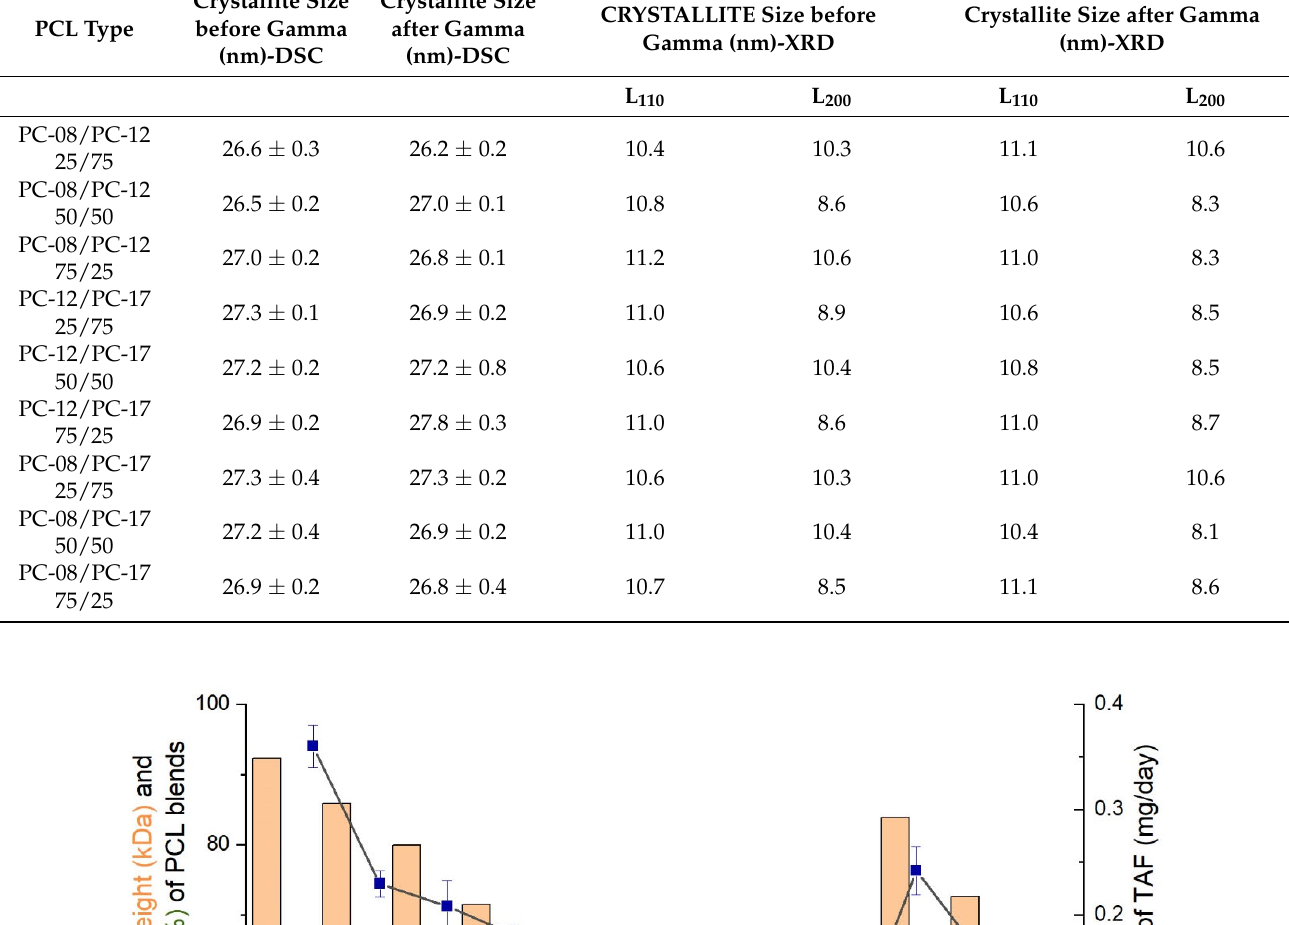
Table 4. Thermal properties of PCL tubes comprising binary blends from XRD and DSC analysis. The extruded tubes had a wall thickness of 100 µ m and an OD of 2.5 mm. The DSC analysis was performed in triplicates, whereas the crystallite size measured by XRD was reported based on a single measurement.